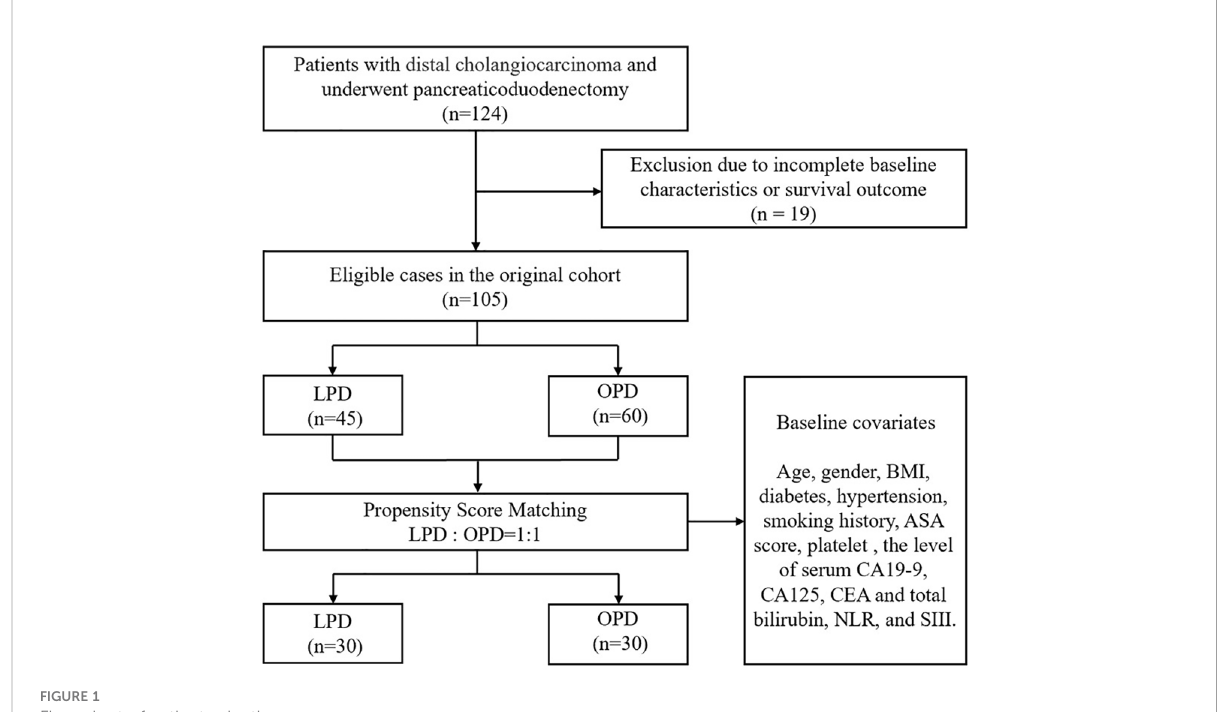
FIGURE 1 Flow chart of patient